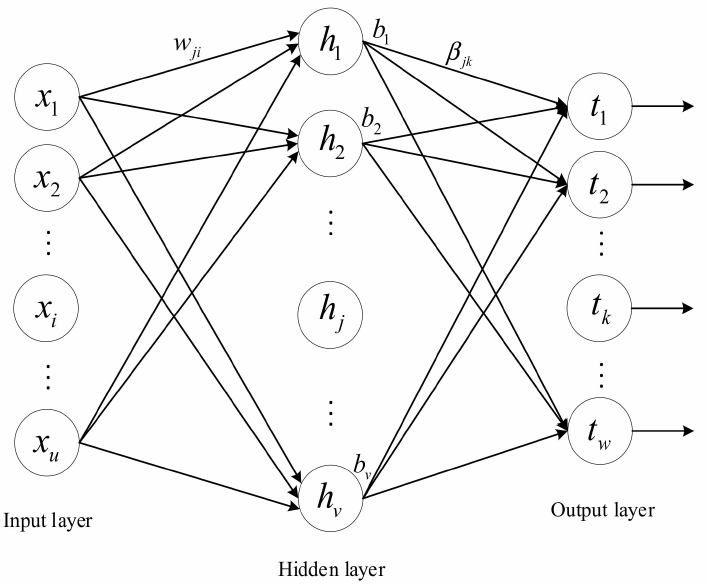
Figure 1. Structure of a single-hidden layer feed-forward neural